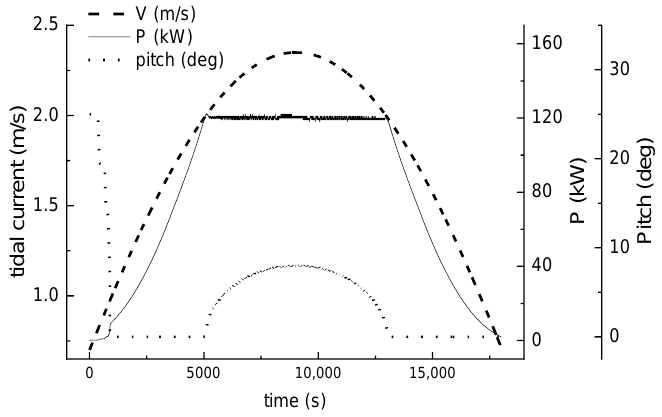
Figure 15. Simulation results of power generation when the maximum flow rate is 2.35 m/s.